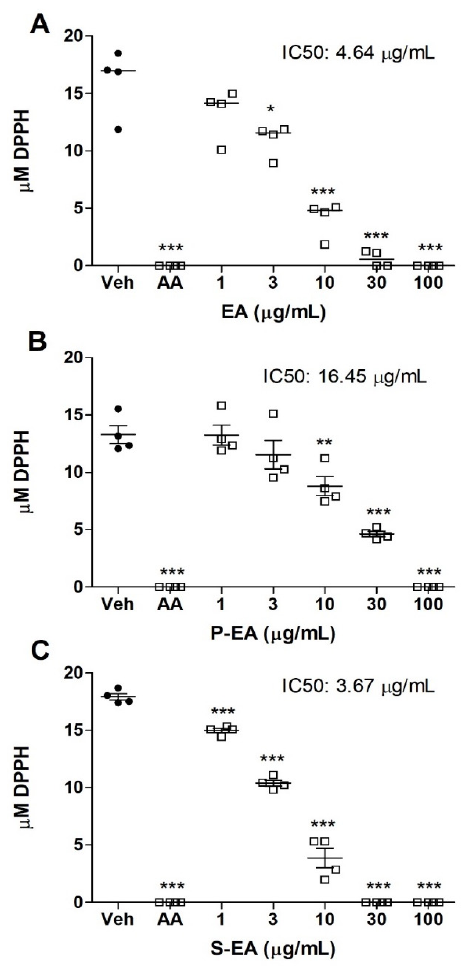
Figure 4. Analysis of the antioxidant effect of L. styraciflua fruits extracts on DPPH radical scaveng- ing. Aqueous (EA) ( A ), polysaccharide (P-EA) ( B ), and Low M w (S-EA) ( C ) extracts were tested at 1–100 µg/mL or 0: negative control (vehicle). AA: positive control (ascorbic acid, 50 µg/mL). Statis- tical analyses were performed by unpaired t -test. Results represent the median of three independent experiments ( n = 4) and * p < 0.05; ** p < 0.01; *** p < 0.001.